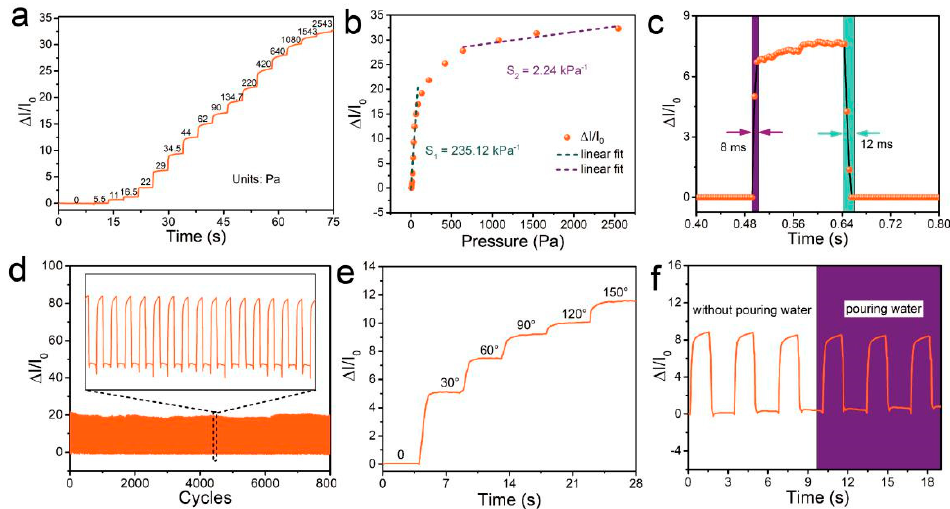
Figure 4. Sensing performance of the pressure sensor. ( a ) Real-time response of the pressure sensor to different degrees of pressure. The applied pressure was increased stepwise using a commercial force gauge (Aliyiqi HF-2N) stepper machine system. ( b ) Relative current change as a function of pressure and linear fitting. ( c ) Time response of the sensor upon applying a quasi-transient step pressure from 0 to 29 Pa. ( d ) Relative current variation under cyclic pressure from 0 Pa to 134 Pa with a frequency of 0.625 Hz over 8000 cycles. ( e ) Relative current change as a function of the bending angle. ( f ) Real-time variation in the relative current. The data were obtained at a stable temperature of about 23 °C.